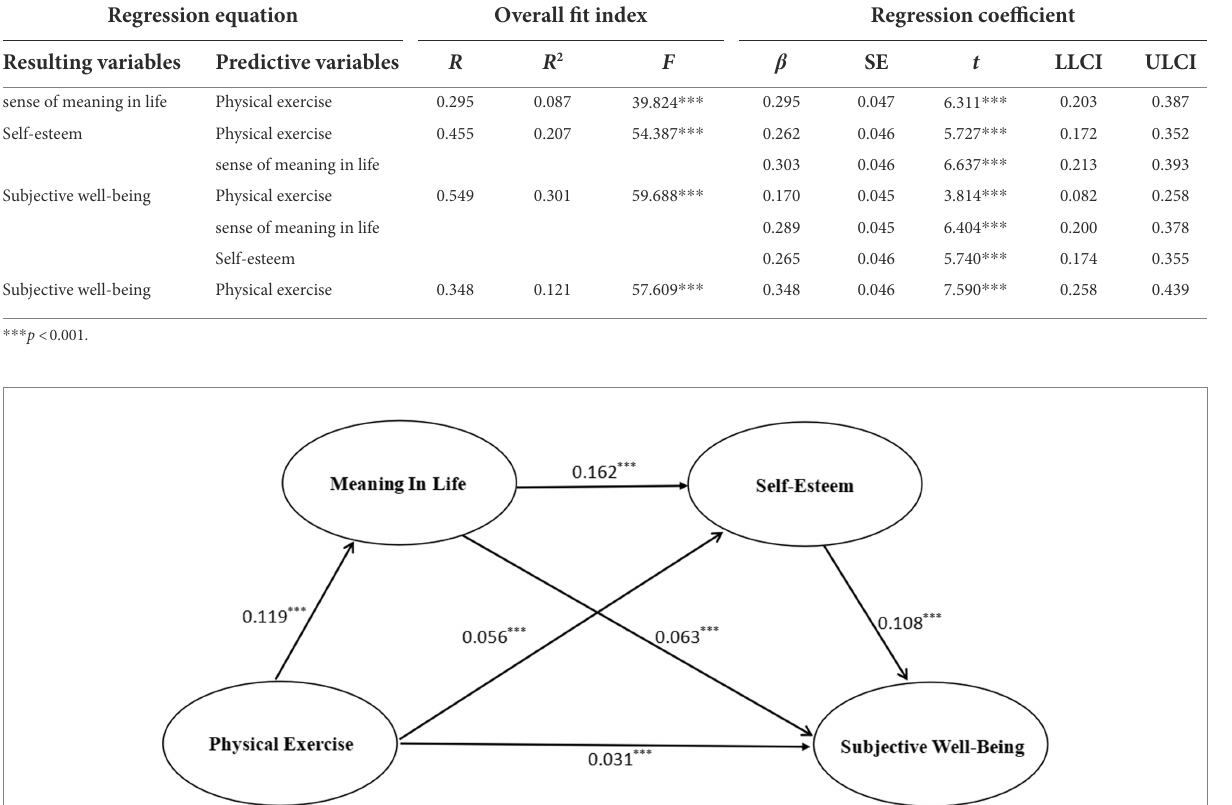
FIGURE 2 Diagram of the chain mediator model of a sense of meaning in life and self-esteem. *** p